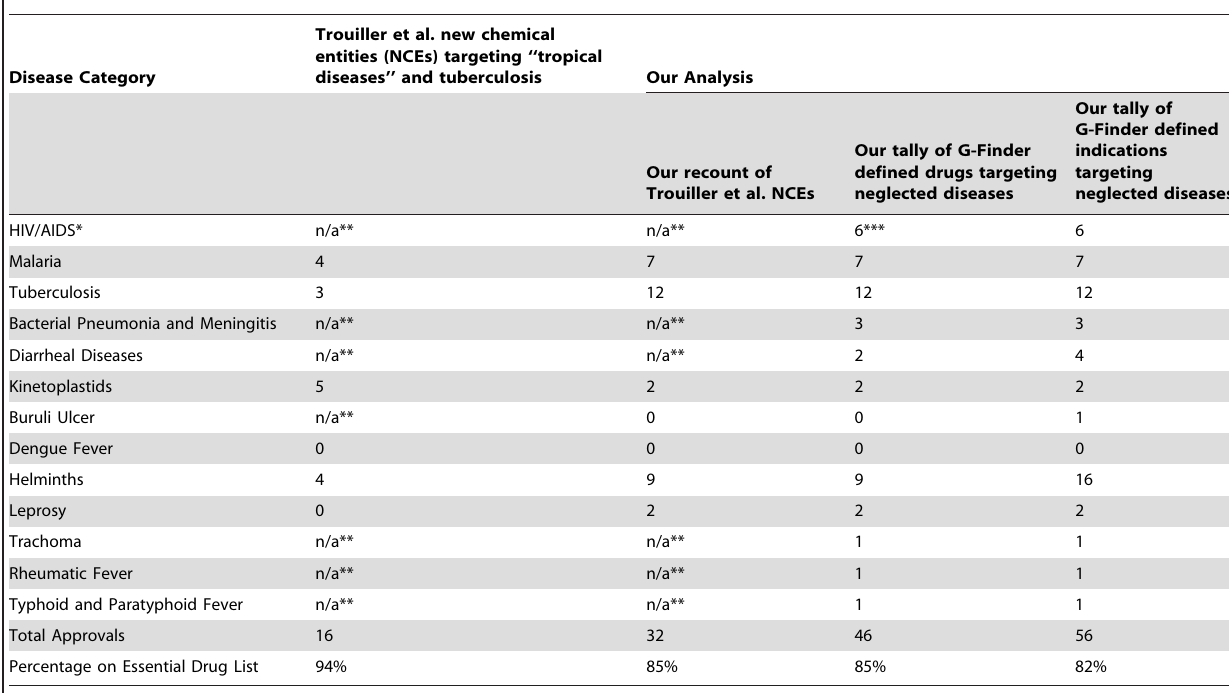
Table 1. Numbers of 1975-1999 Approvals for Neglected Diseases.